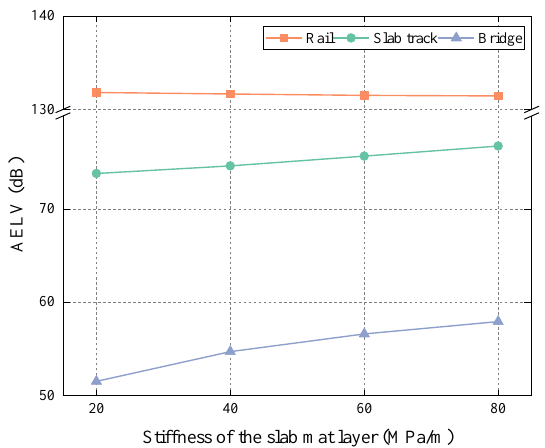
Figure 9. The AELVs of the track – bridge system. Figure 11. The AELVs of the track–bridge